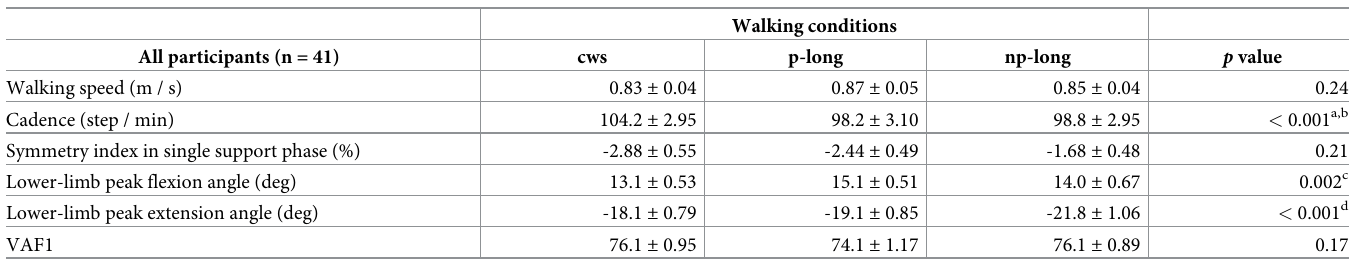
Table 2. Spatio-temporal parameters between walking conditions in all participants.